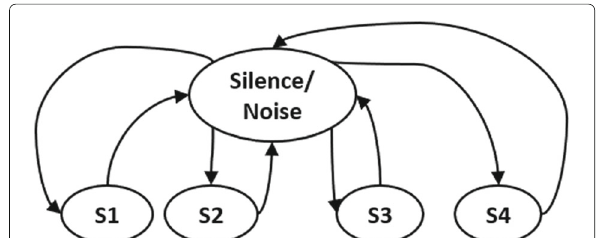
which are classified and later processed for a precise local- ization. Heart beat is a repetitive or cyclic process (Fig. 2) and a normal PCG signal can be divided into four seg- ments. These include the time window containing S1, the silence window, the segment containing S2, and again the silence window. A normal heart beat can hence be modeled using these states. However, since the sequence and duration of each state within the cycle can vary, probabilistic modeling is better suited for such scenarios as opposed to deterministic approaches. Hidden Markov model (HMM), for instance, has been employed for such modeling in [15–17]. The same idea can be extended to include the abnormal beats S3 and S4 (and different other pathologies) as illustrated in Fig. 3. Such techniques allow pre-classifying these segments into one of the states while the exact location of beats within these segments are localized